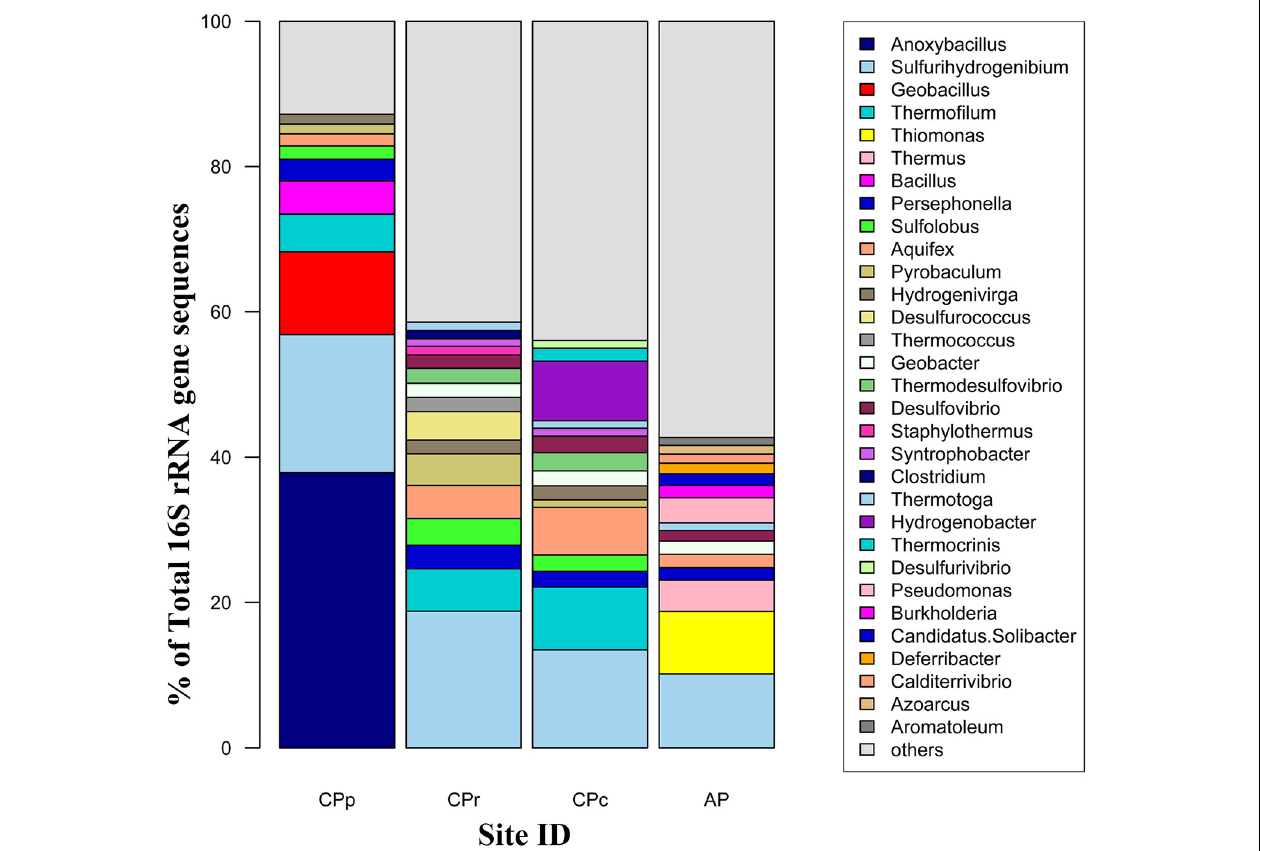
FIGURE 4 | Distribution of microbial 16S rRNA gene sequences (classified to genus level) at the four sample sites at Champagne Pool. CPp, central pool; CPr, rim of pool; CPc, outflow channel; AP, “Artist’s Palette” terrace. “Others” category in legend signifies genera present at < 1% each.